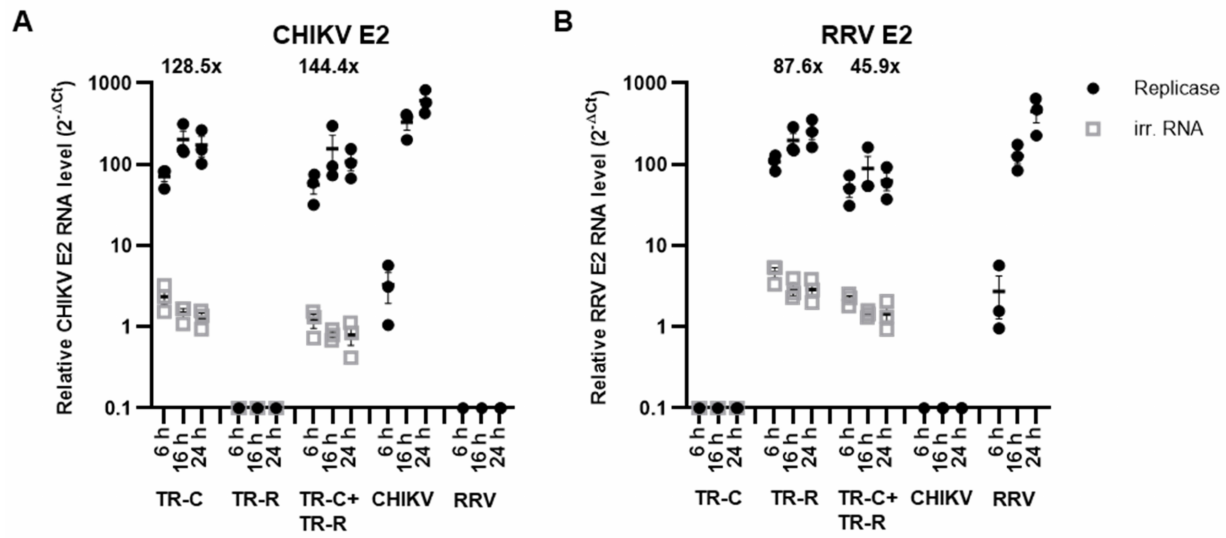
Figure 2. TR-RNA amplification by the CHIKV replicase. HEK 293T cells were transfected with 2 µ g of the replicase RNA or TR-luc-RNA as irrelevant RNA together with 0.5 µ g of the indicated TR-RNAs. The total amount of TR-RNA was kept constant between the single and double transfections. For comparison, cells were infected with CHIKV or RRV (MOI 3). RNA was harvested after 6 h, 16 h, and 24 h, and ( A ): CHIKV E2 and ( B ): RRV E2 RNA levels were measured by RT-qPCR. Numbers indicate the fold change in TR-RNA amount 24 h after co-transfection with the replicase. Ct values, which were below the cutoff, were set to 0.1 for plotting. Data are mean values ± SEM of three independent